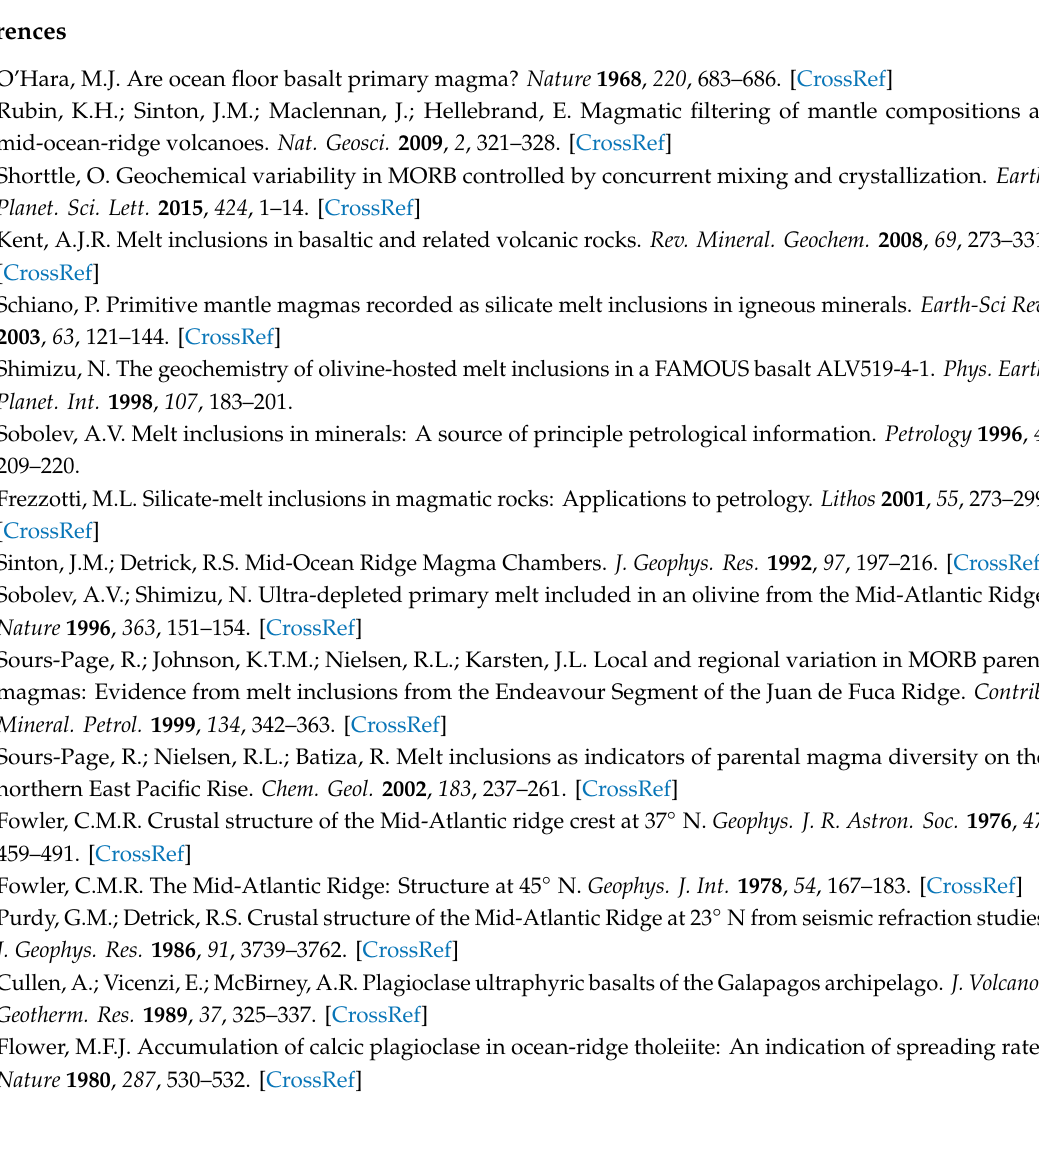
Figure S1: Backscatter electron images and chemical transects for two selected plagioclase macrocrysts, Table S1: Analytical results of XRF standards, Table S2: Analytical results of ICP-MS standards, Table S3: plagioclase compositions, Table S4: PUB host glass compositions, Table S5: compositions of plagioclase-hosted melt inclusions after PEC